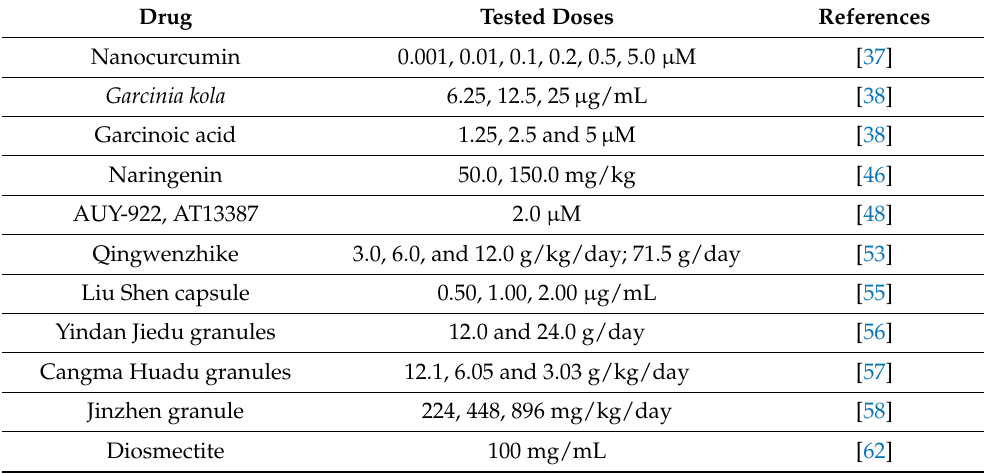
Table 1. Proposed therapeutical doses of selected